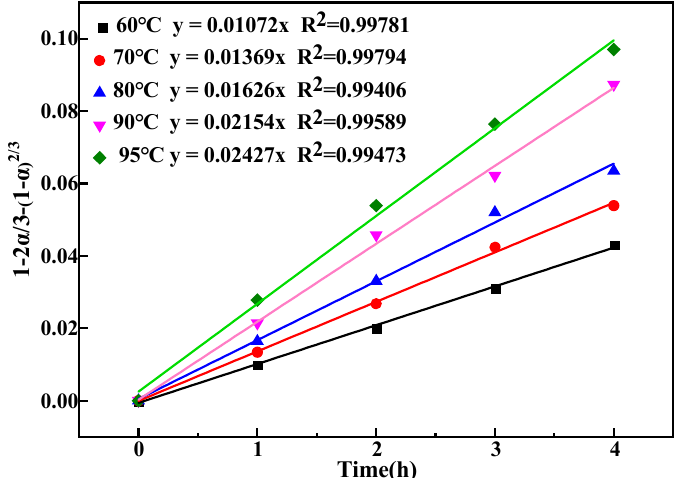
Figure 7. Plots of 1 − (1 − α ) 1/3 versus time at different temperatures.